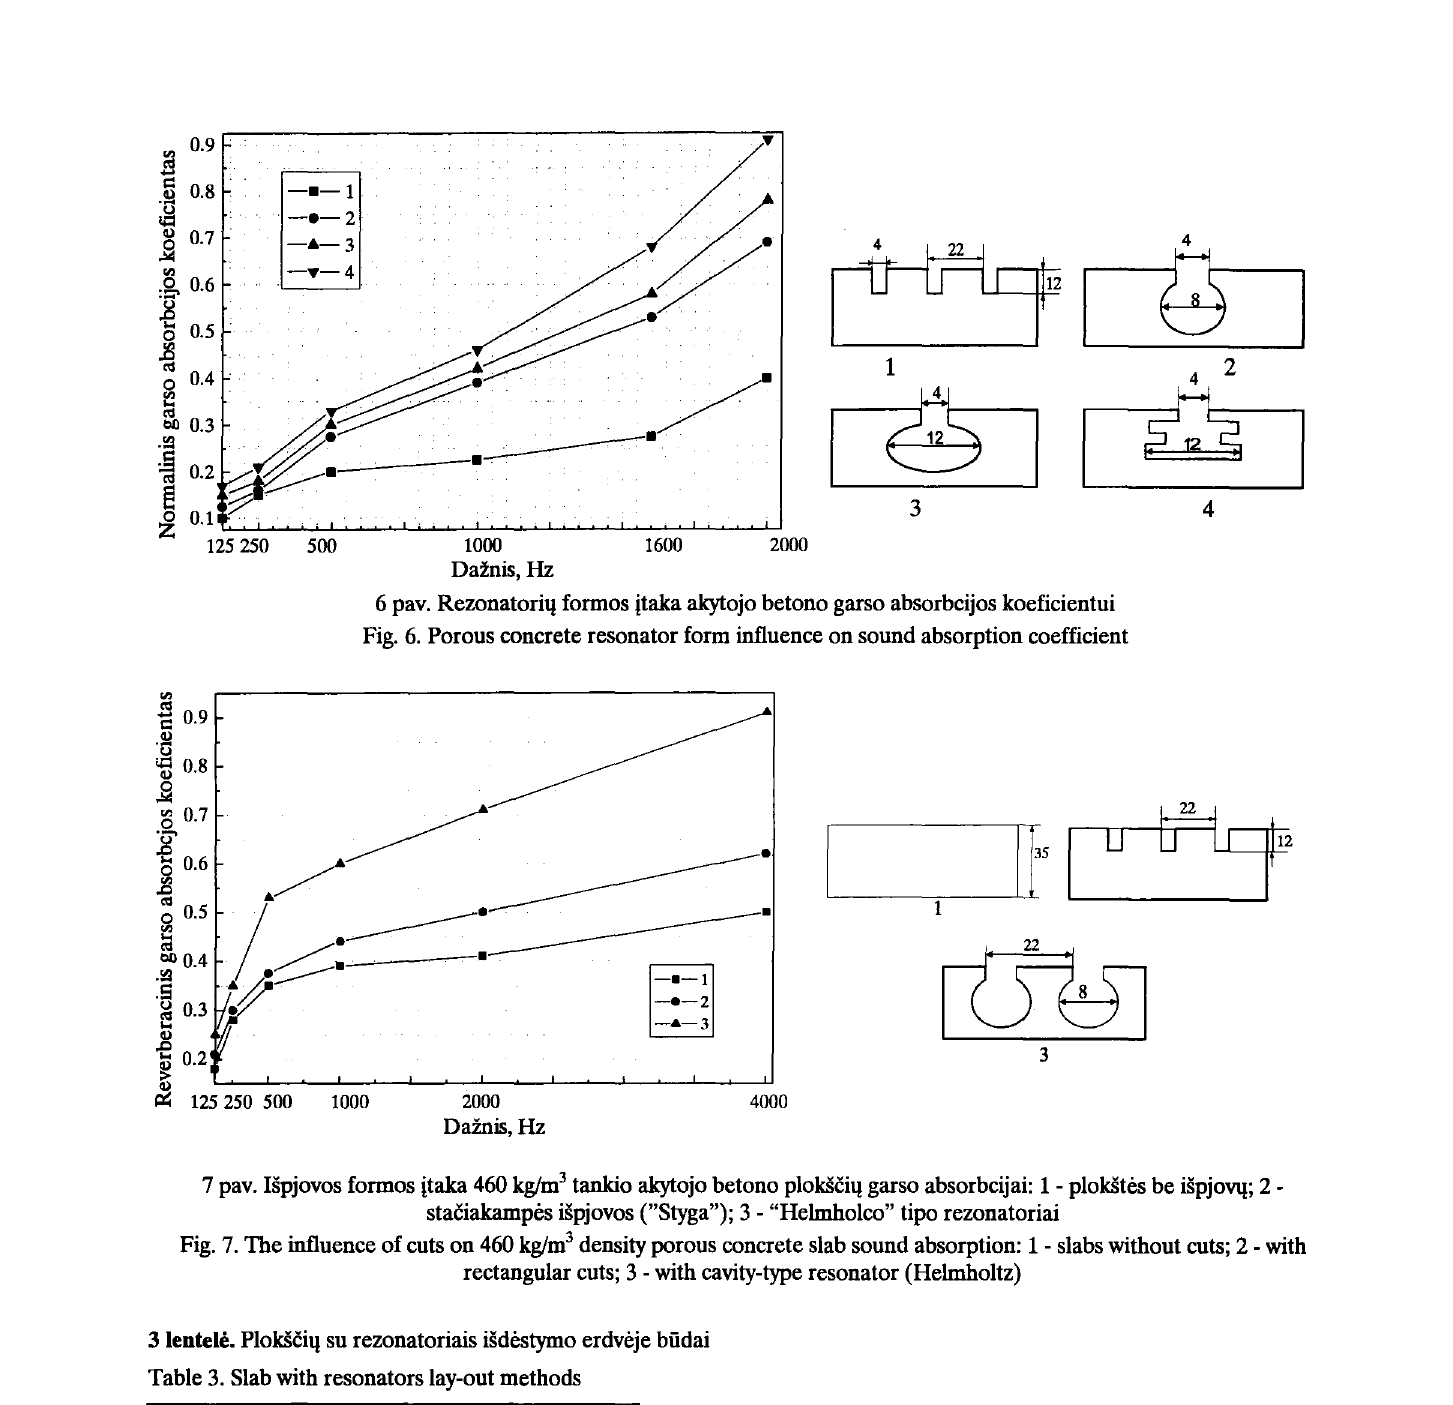
Fig. 7. The influence of cuts on 460 kg/m 3 density porous concrete slab sound absorption: 1 - slabs without cuts; 2 - with rectangular cuts; 3- with cavity-type resonator (Helmholtz) 3 lentele. PlokSciq su rezonatoriais isdestymo erdveje biidai Table 3. Slab with resonators lay-out methods Kreives